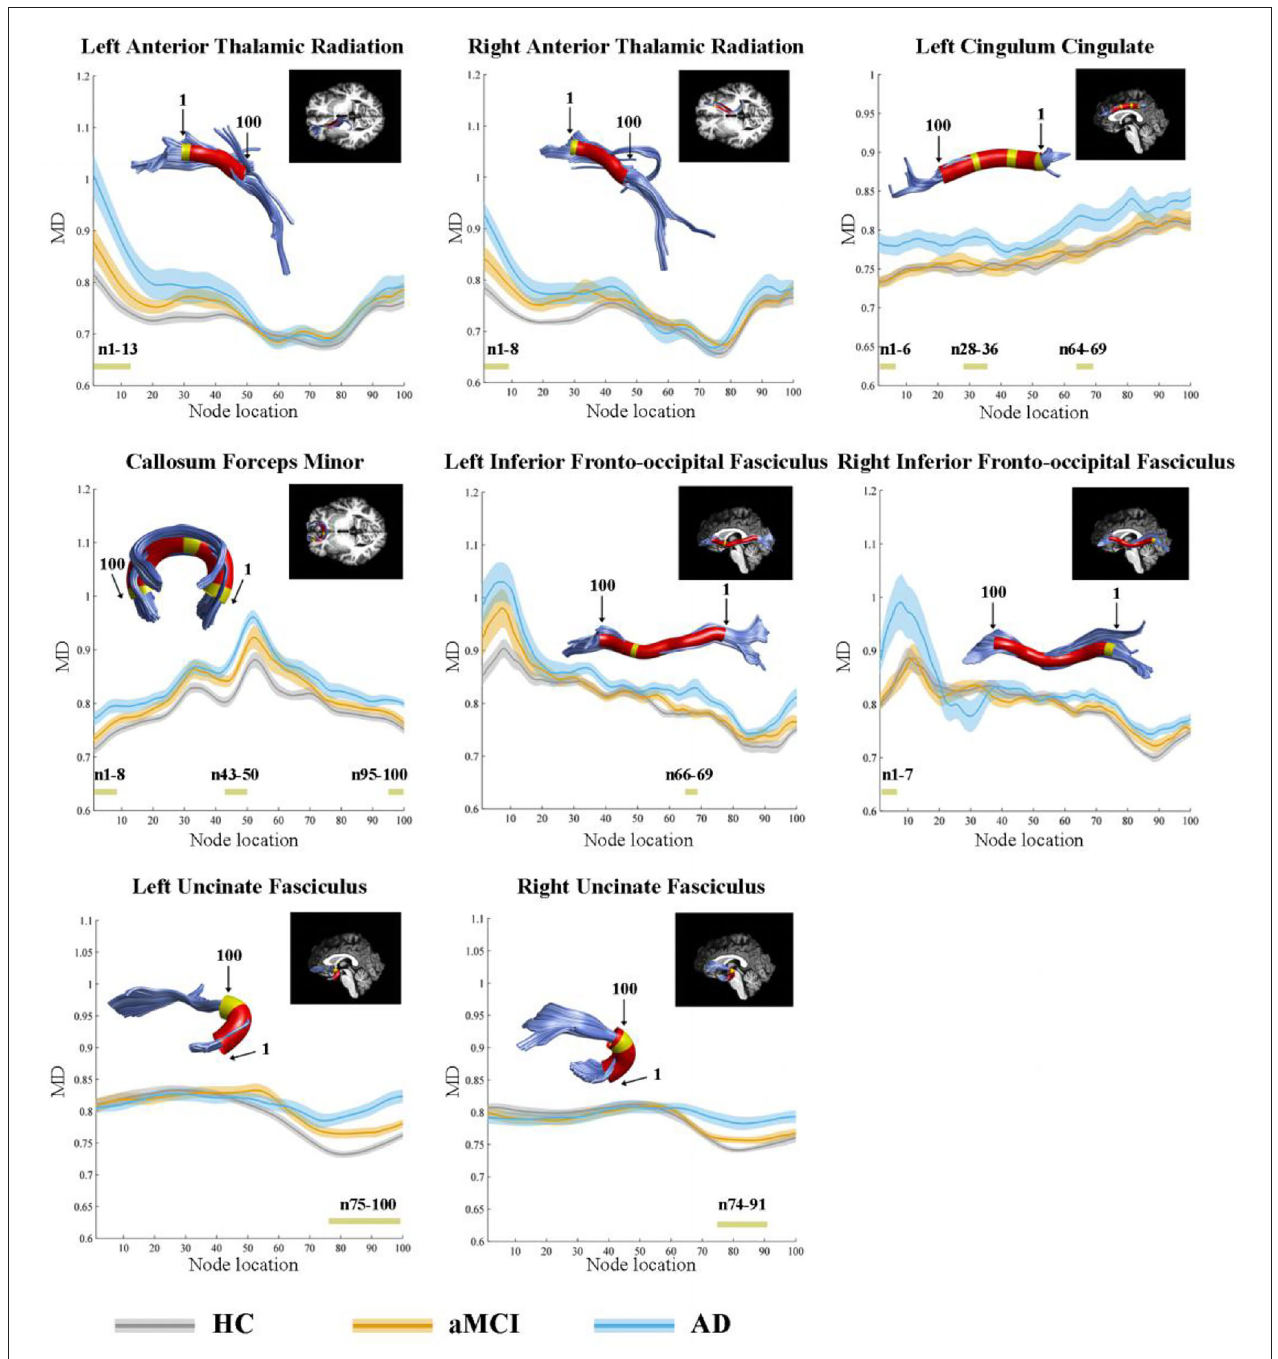
FIGURE 1 | Significantly altered MD values in point-wise of fiber tracts (FDR correction, p < 0.05). Yellow color in the white matter tracts represents significantly altered locations. Red color in the white matter tracts represents other locations with no statistical significance. HC, health control; aMCI, amnestic mild cognitive impairment; AD, Alzheimer’s Disease; MD, mean